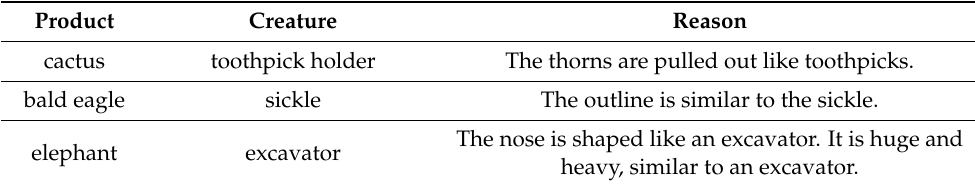
Table 6. Creature form- product form reasoning (60 times).